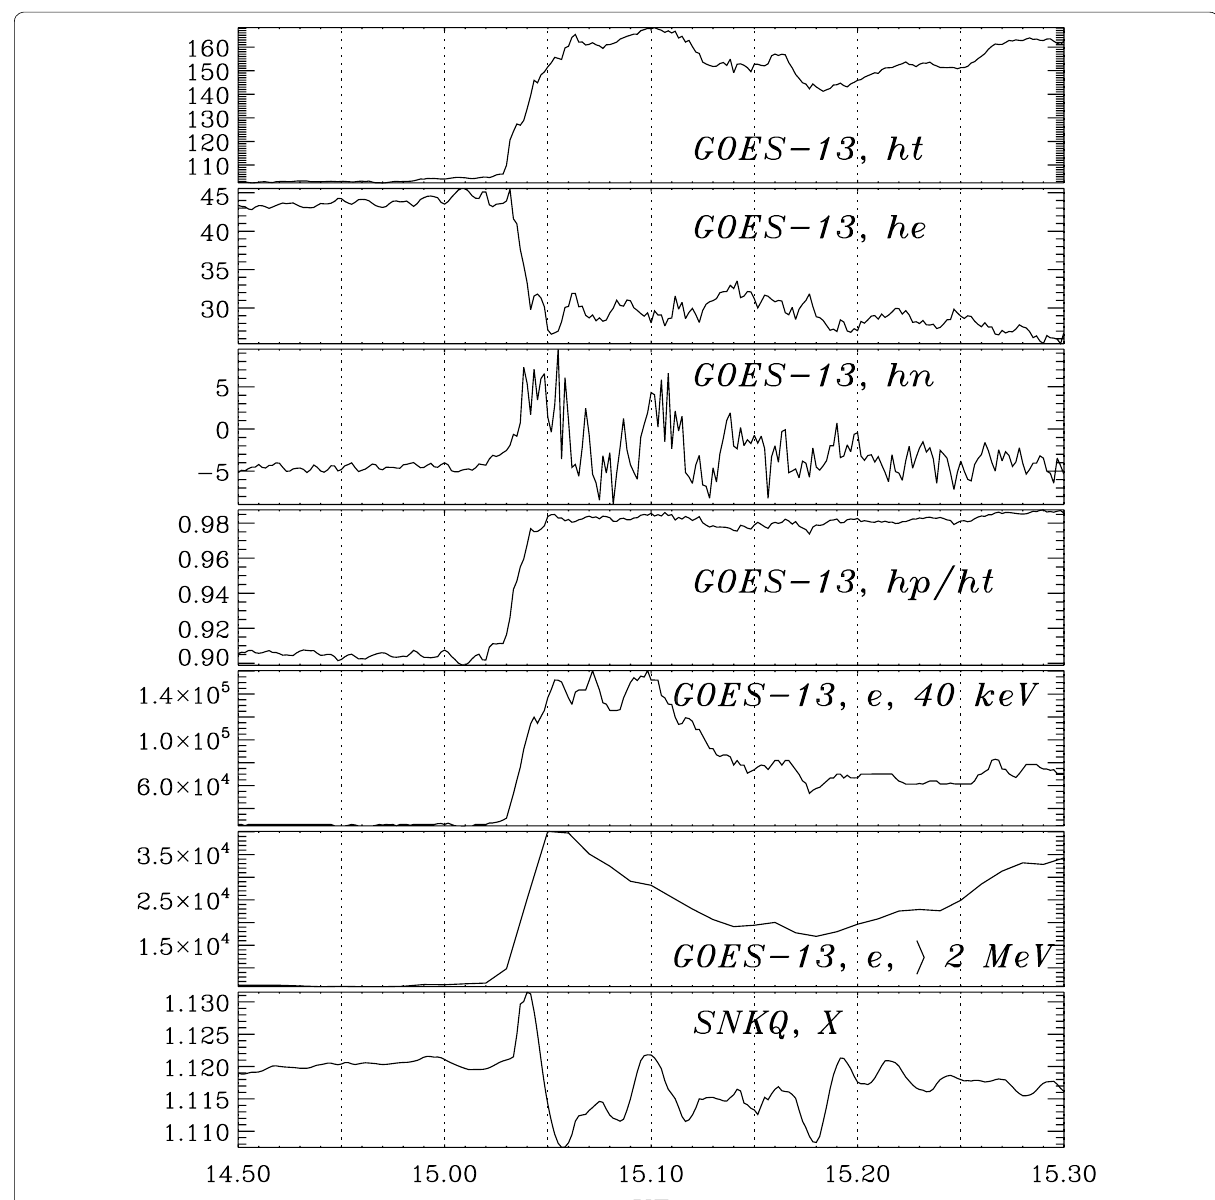
Fig. 7 The magnetometer [magnetic field B e , B n , and B p / B t components in (nT)] and particle (fluxes of electrons J e with E (cm 2 s sr)] data from the geosynchronous satellite GOES-13 and conjugate ground station SNKQ [X-component in (10 4 nT)] during the time